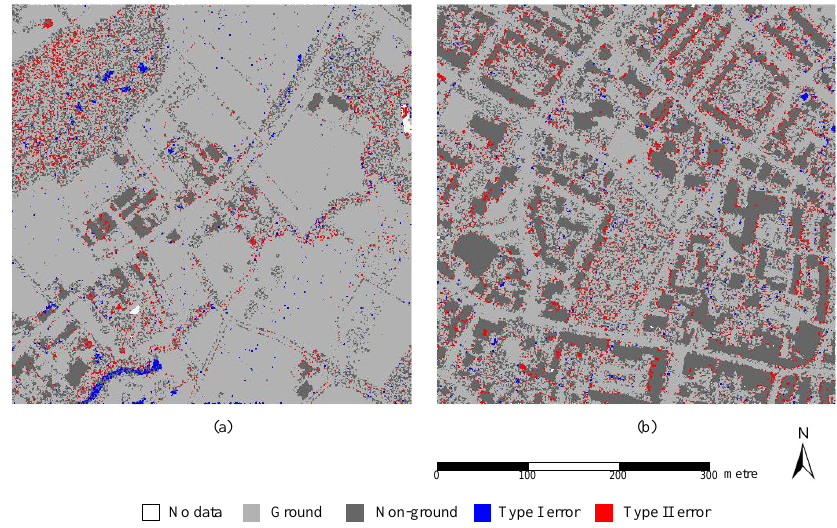
Figure 16. Error distribution of the proposed method filtering AHN data: ( a ) result of AHN Test Site 1; and ( b ) result of AHN Test Site 2.